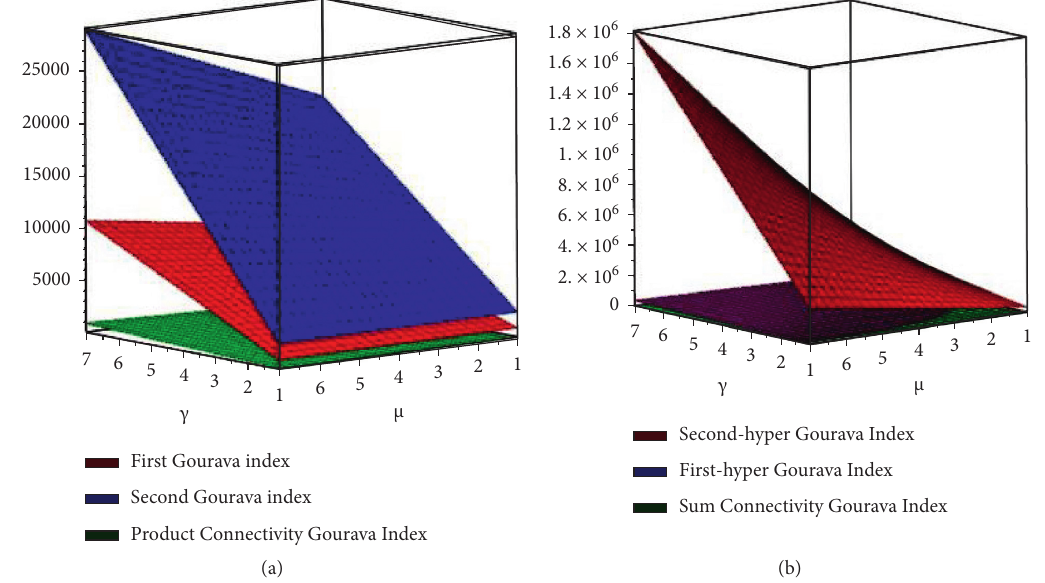
Figure 12: Graphical illustration of Gourava indices for GL c μ . (a) The first and the second Gourava indices and Gourava hyper-indices. (b) The sum and the product Gourava connectivity indices.